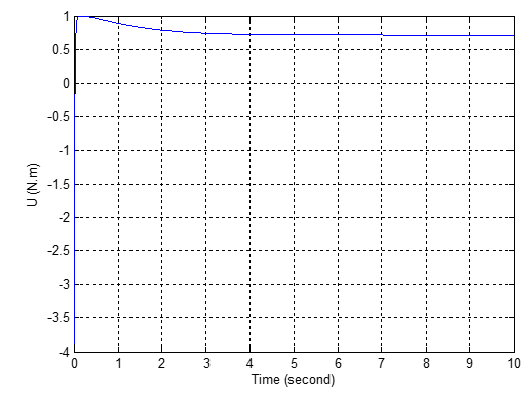
Fig. 14. The control action c vs. time of the CSMC. vs. time of the CSMC.